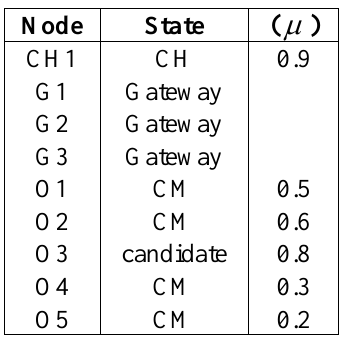
Table 1. Information for C1.